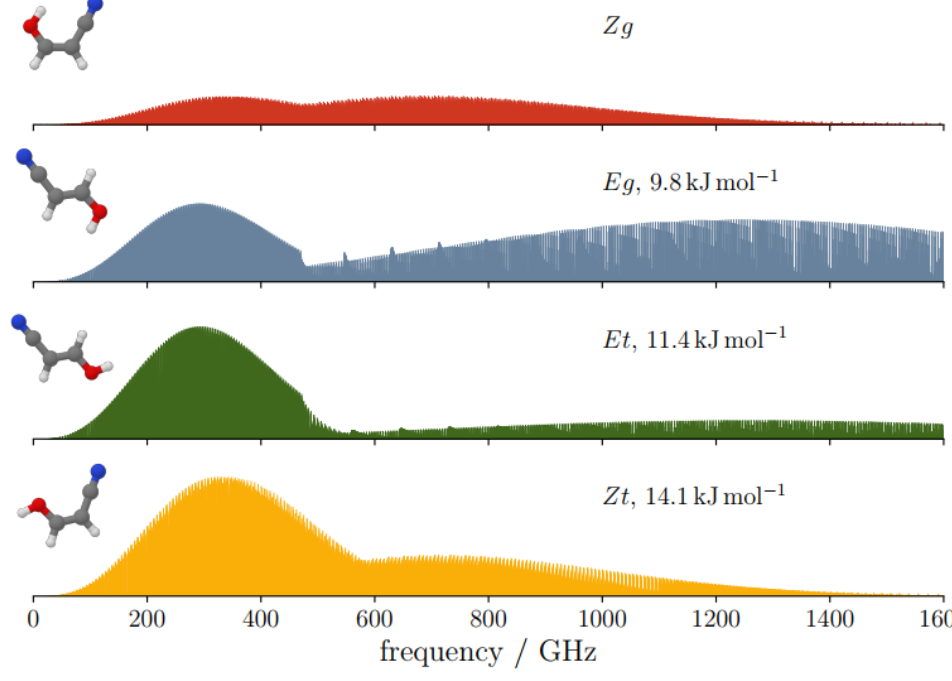
Figure 4. Simulated rotational spectra of the four isomers of cyanovinylalcohol based on the computed constants reported in Table 2. The calculations were performed for J ranging in the 0–100 interval and T = 300K. The y -axes are normalized with respect to the most intense Zt spectrum. The relative energy at the CBS + CV+aZPE level of theory is provided with respect to the most stable isomer ( Zg